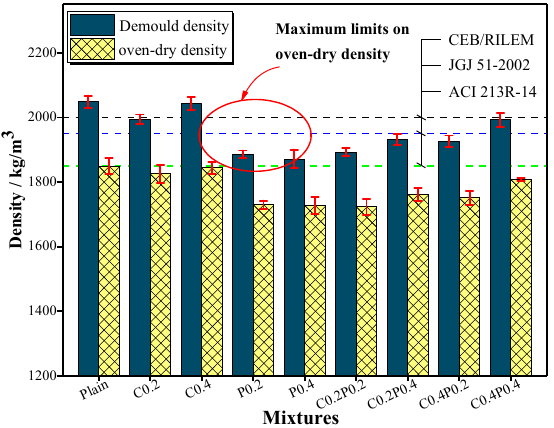
Figure 5. Density for LWAC reinforced with carbon and/or polypropylene fibers.